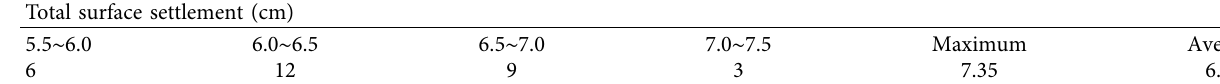
Table 3: Statistics of total surface settlement (30 sections).